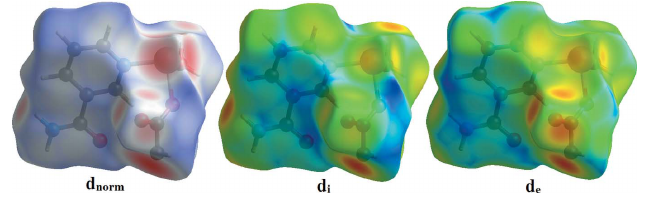
Figure 3 The Hirshfeld surface of the title compound mapped over d norm , d i and d e .